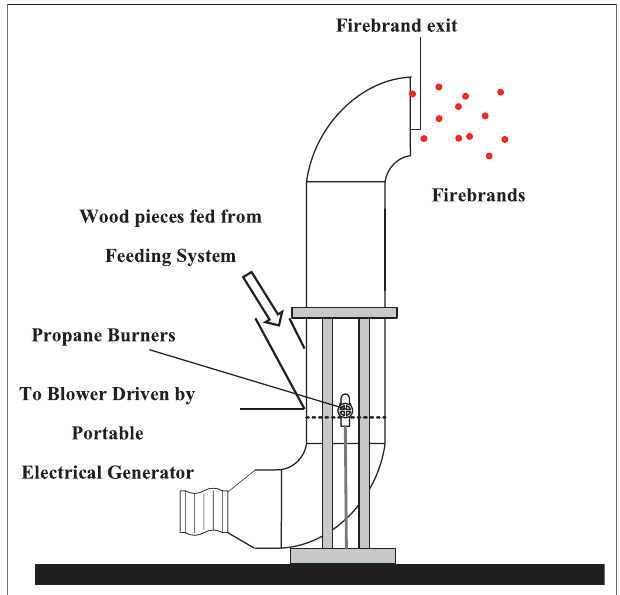
FIGURE 1 | The continuous-feed fi rebrand generator (the continuous- feed NIST Dragon).